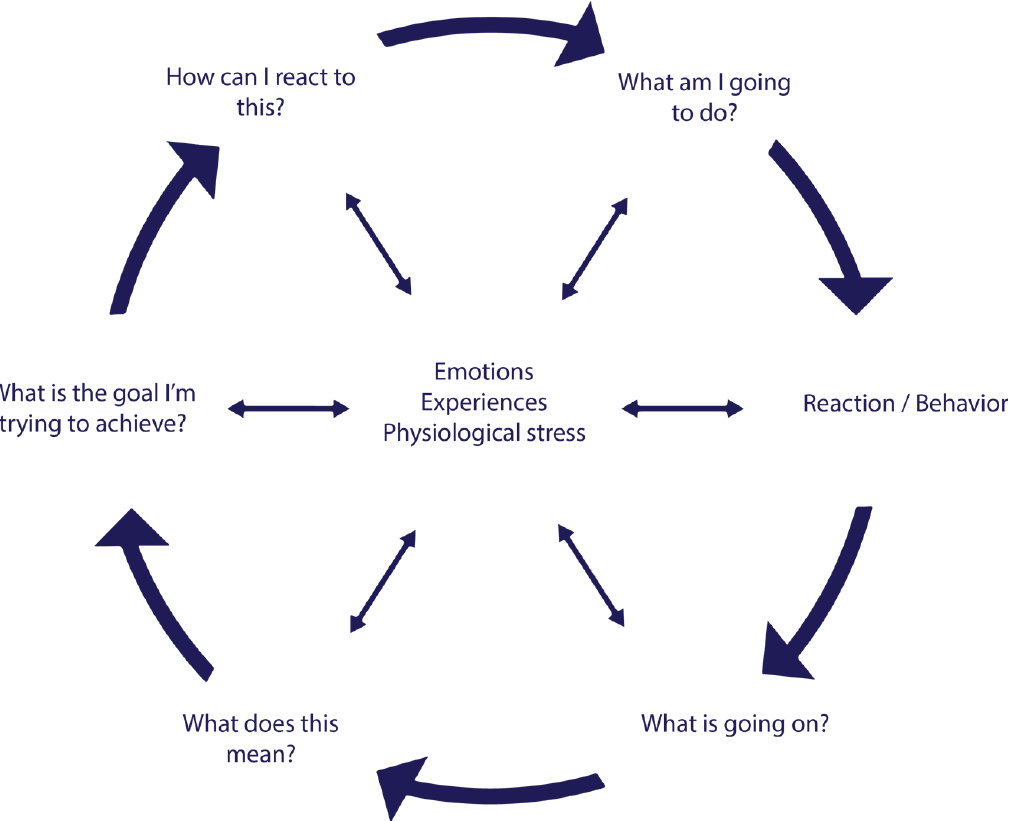
Figure 2. Theoretical framework of VRAPT. Based on the social information processing (SIP) model of Crick and Dodge